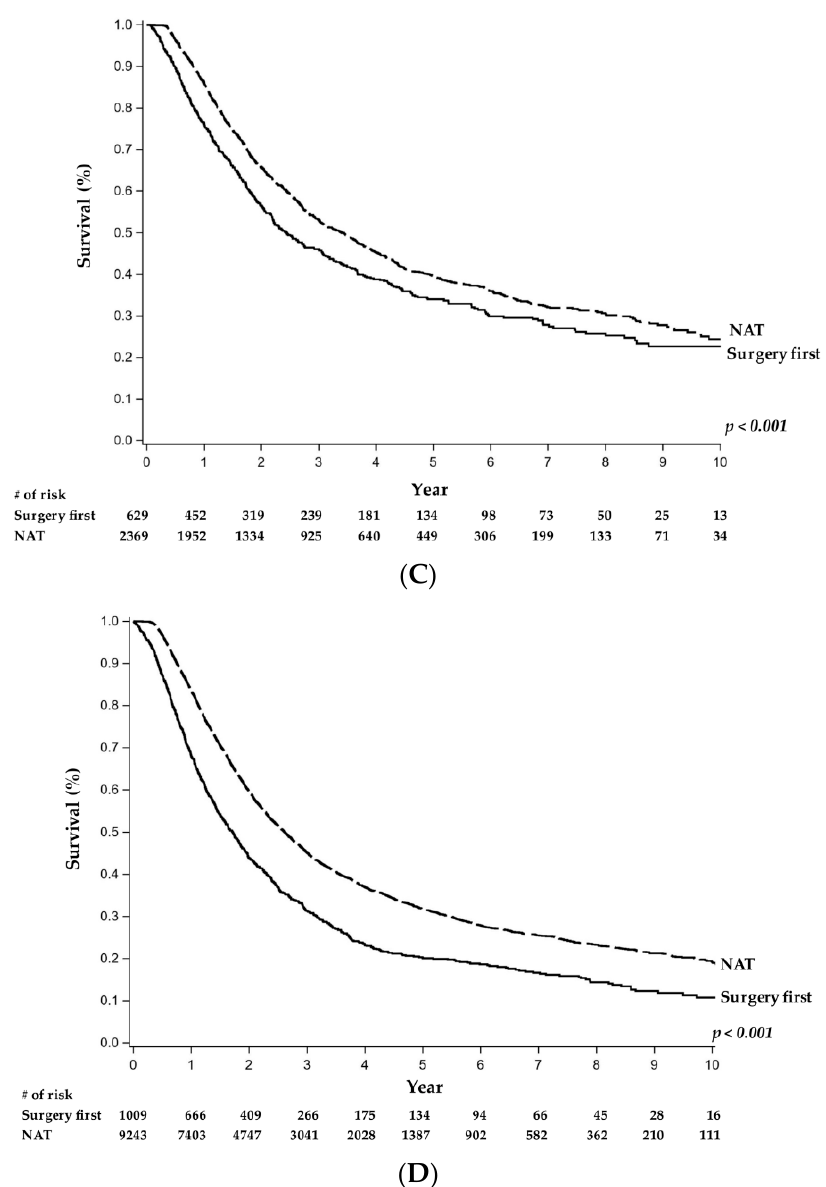
Figure 2. Overall survival analysis comparing patients with gastroesophageal junction adenocarcinoma who received upfront surgery to those who first received neoadjuvant therapy across all clinical stages: ( A ) early localized (T1-2N0), ( B ) locally advanced (T3-4N0), ( C ) regional (T1-2N + ), and ( D ) regionally advanced (T3-4N + ). Abbreviations: NAT, neoadjuvant therapy. #, number.